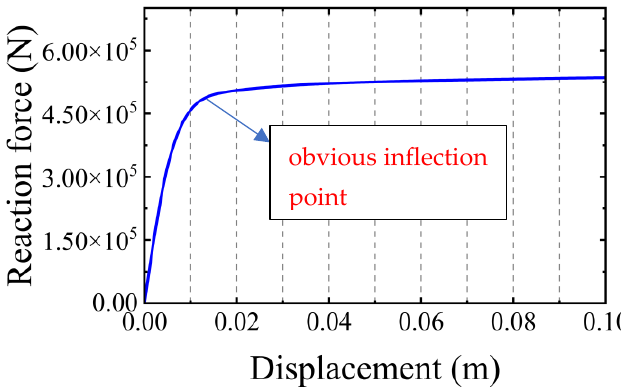
Figure 11. Numerical simulation result curve.